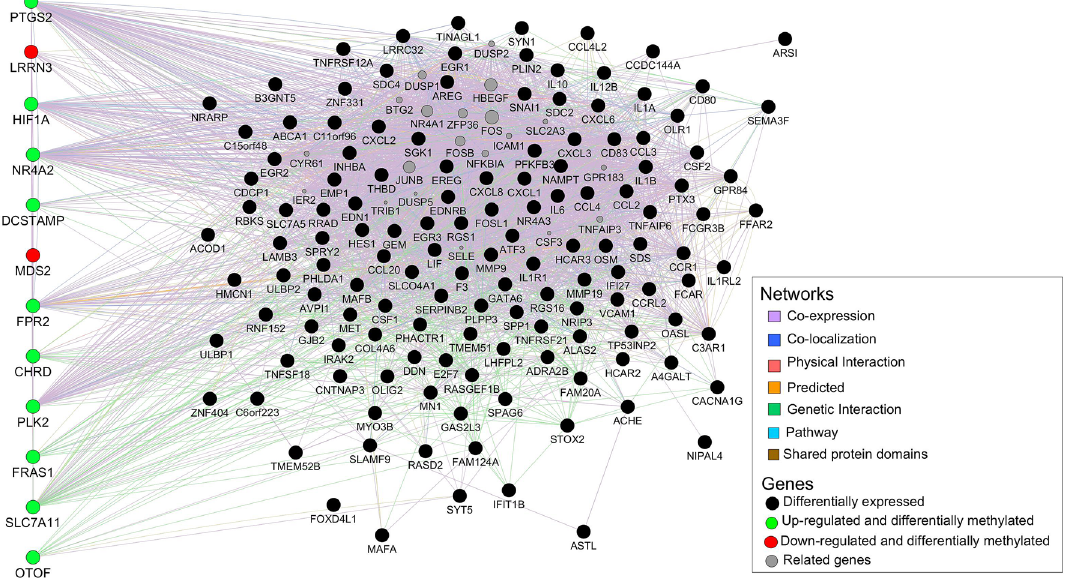
Figure 6. Network for differentially expressed genes in individuals failing cART. Different types of network were identified among the 187 transcripts associated with virologic failure. Genes with methylation and gene expression correlation are showed in the left. HLA-V is a pseudogene and was not